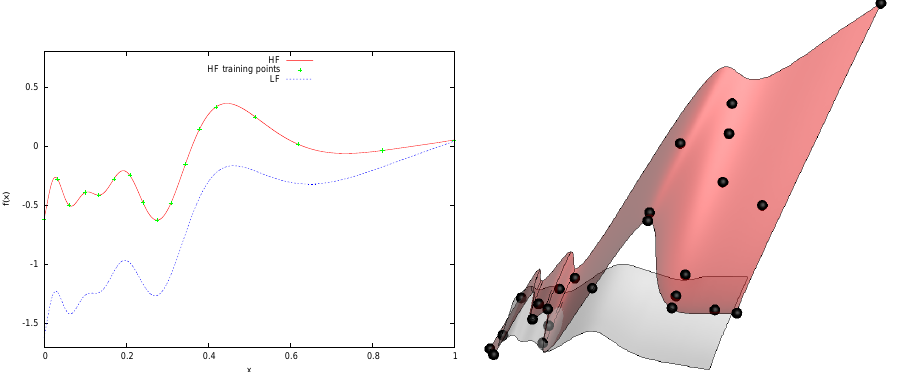
Figure 5. Plot of one- ( left ) and two-dimensional ( right ) HF and LF ALOS functions with initial HF training